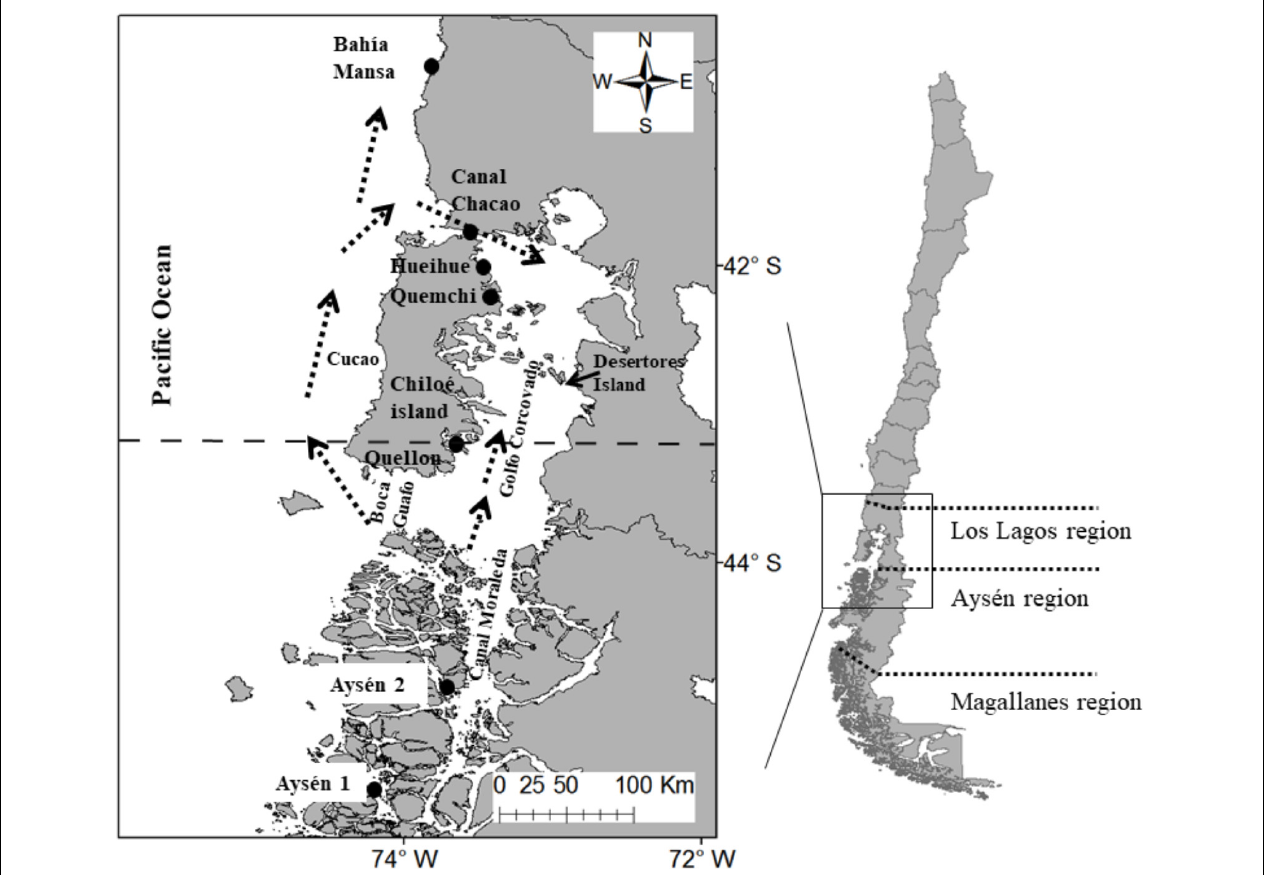
FIGURE 1 | Localities from where the clones were isolated (black circles): Aysen 1, Aysén 2, and Quellón, the populations from northern limit of the known distribution of A. catenella up to 2015, where the clones were isolated from cysts beds in 2014. Quemchi, Hueihue, Canal Chacao, Bahía Mansa, the populations isolated from vegetative cells of the 2016 bloom, isolate from opportunistic sampling. Arrows show a hypothesized route of the spread of the 2016 bloom. Horizontal dotted lines illustrate both the political boundary of the regions (right) and the horizontal segmented line show distribution limit of the species up to 2015 (left) .